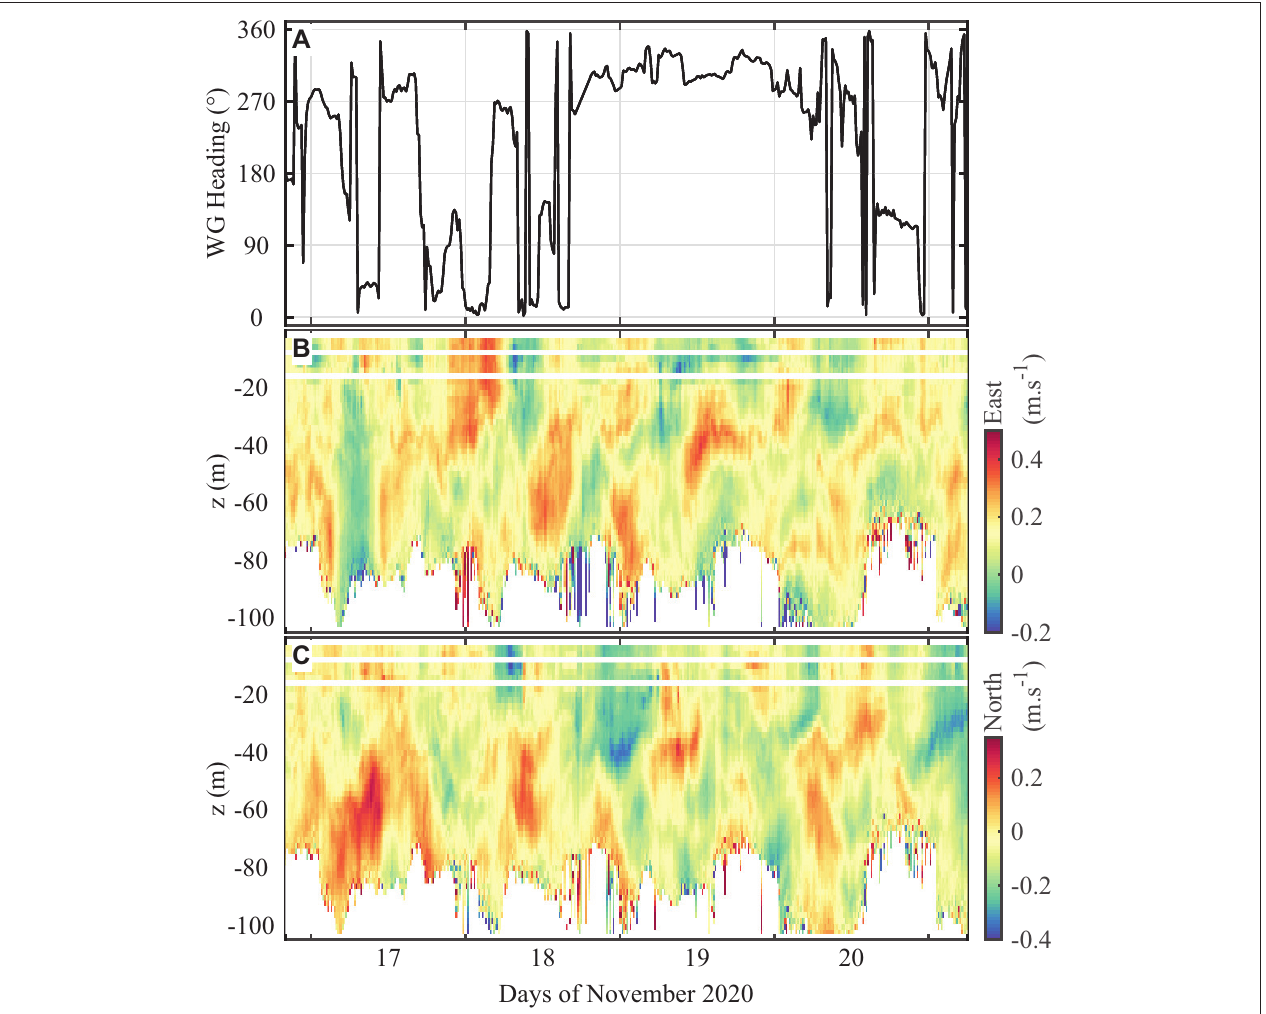
FIGURE 6 | (A) Heading angle of the platform, (B) east current, and (C) north current components measured by the SV3 Wave Glider Planck during the TFOex2020 experiment. The measurements at 8 and 16 m were discarded because they were contaminated by side-lobe reflection due to the sub fins. Current measurements were performed by a 300 kHz downward-looking ADCP. These current profiles are the motion-compensated, averaged products computed in real-time by the payload and sent back to shore via Iridium satellite communications every 15 min. Each individual 1 s ADCP ping is corrected for the velocity of the platform and, subsequently, the current profiles do not exhibit any correlations with the heading of the Wave Glider that had been observed previously when motion compensation was executed after averaging over longer duration, multiple ping